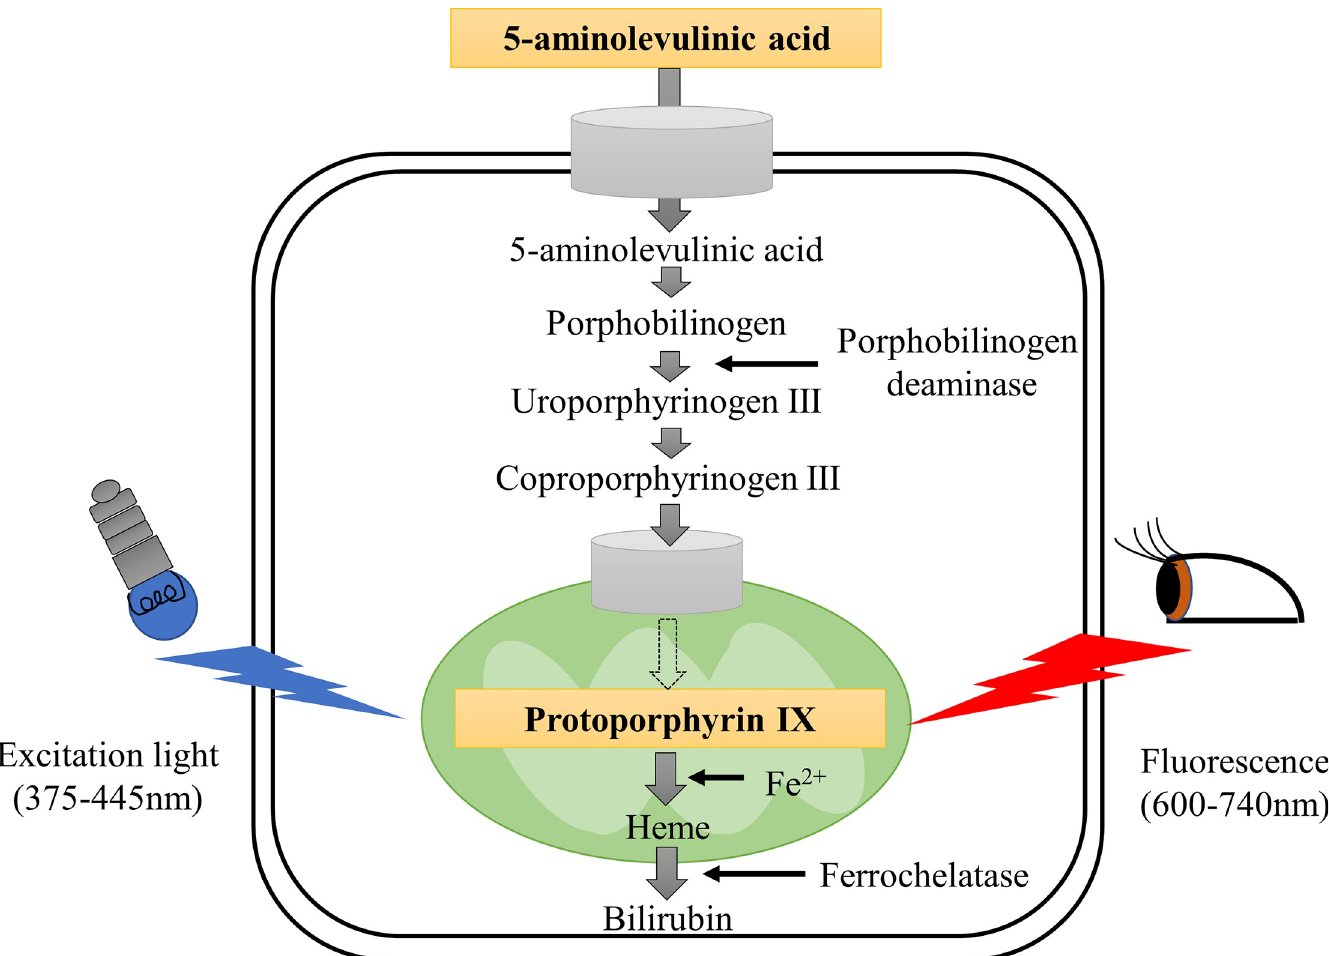
Fig 1. Schematic illustration of PpIX-metabolizing pathway and mechanism of PDD. 5-ALA is a metabolic precursor of heme in the heme synthesis pathway and is further metabolized into PpIX. PpIX emits red fluorescence (600–740 nm) when excited with blue-violet light (375–445 nm).